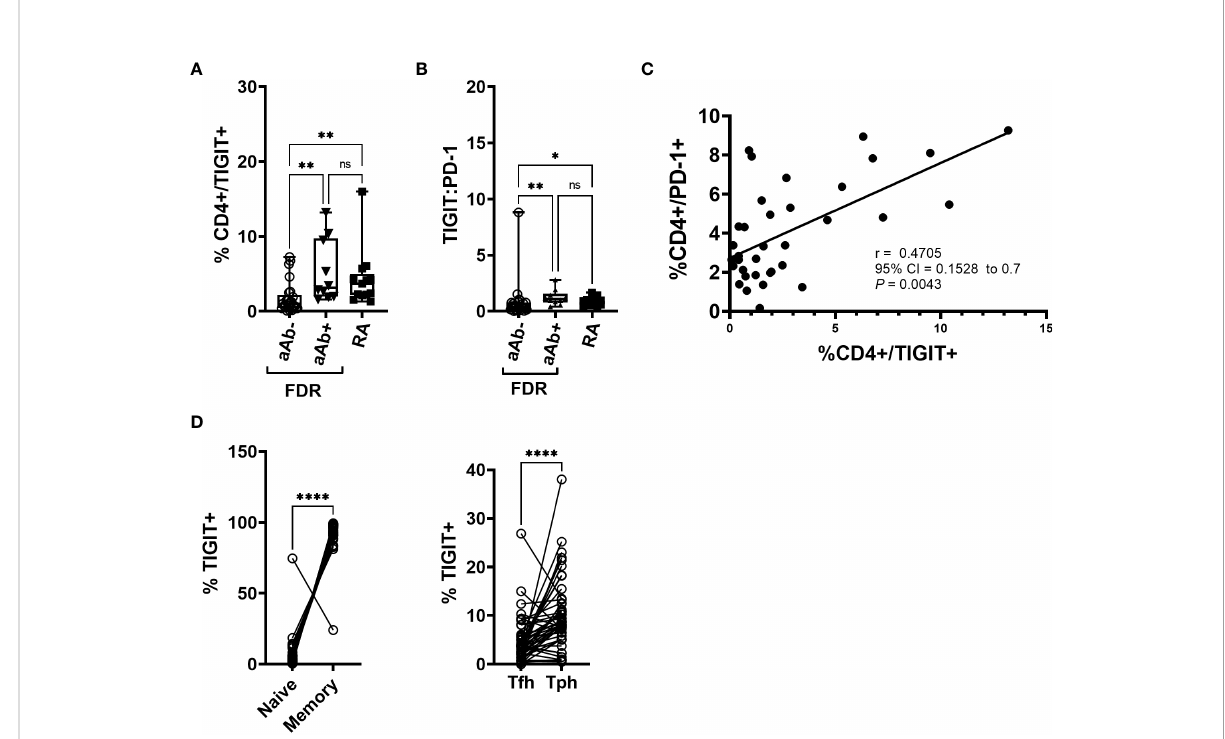
FIGURE 1 (A) Box-whiskers plot showing the frequency of CD4+ cells positive for TIGIT between aAb-FDR (n=25), aAb+FDR (n=10) and RA patients (n=13). *P<0.05, **P<0.01; Data was analyzed using Kruskal-Wallis method with Dunn ’ s post-hoc test. (B) Box-whiskers plot showing TIGIT: PD-